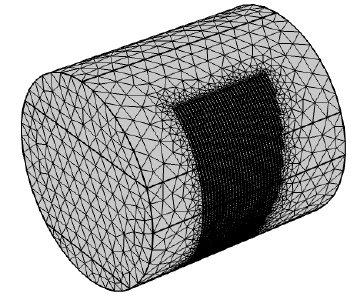
Figure 7. Meshed 3D model of the conductance sensor in COMSOL. Table 2. The electrical properties of materials used in FEA model.